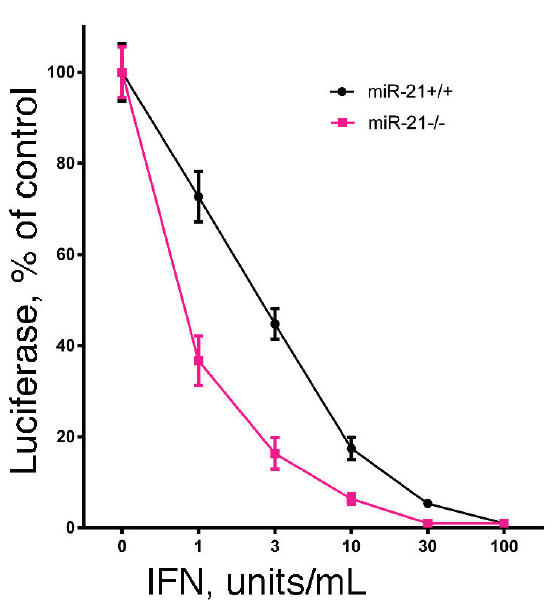
Figure 2. The effect of miR-21 deficiency on the sensitivity of mouse embryo fibroblasts to the antiviral action of IFN. Mouse embryo fibroblasts from miR-21 knockout mice or their wild-type littermates (generously provided by Dr. Mark Hatley, St. Jude Children’s Research Hospital, Memphis, TN, USA) were added to 48-well plates (1 × 10 4